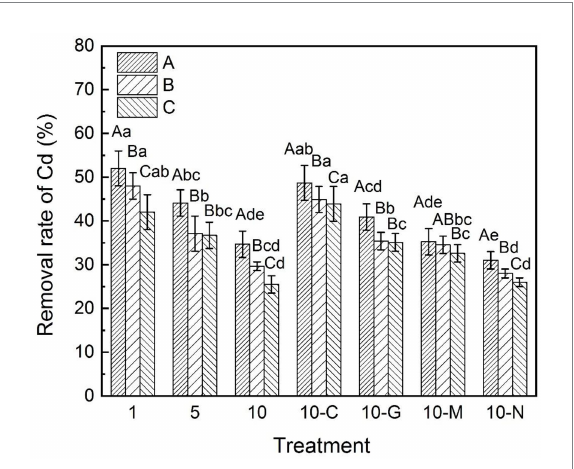
FIGURE 4 Removal rate of cadmium under different types of soil. The values shown are the mean ± SE ( n = 3). Differences sampled indicated by capital letter are between soil types, and by lower- case letter are Cd/exudates related. The same letters among specific treatments are not significantly different according to Duncan’s (0.05). A, B, and C represent sandy, loamy, and clayey, respectivly. Treatments: 1, 1 mg kg − 1 cadmium ion-contaminated soil; 5, 5 mg kg − 1 cadmium ion-contaminated soil; 10, 10 mg kg − 1 cadmium ion-contaminated soil; 10-C, 10 mg kg − 1 cadmium ion- contaminated soil with the addition of 20 ml citric acid solution at 50 mmol L − 1 , 10-G, 10 mg kg − 1 cadmium ion-contaminated soil with the addition of 20 ml glycine solution at 50 mmol L − 1 ; 10-M, 10 mg kg − 1 cadmium ion-contaminated soil with the addition